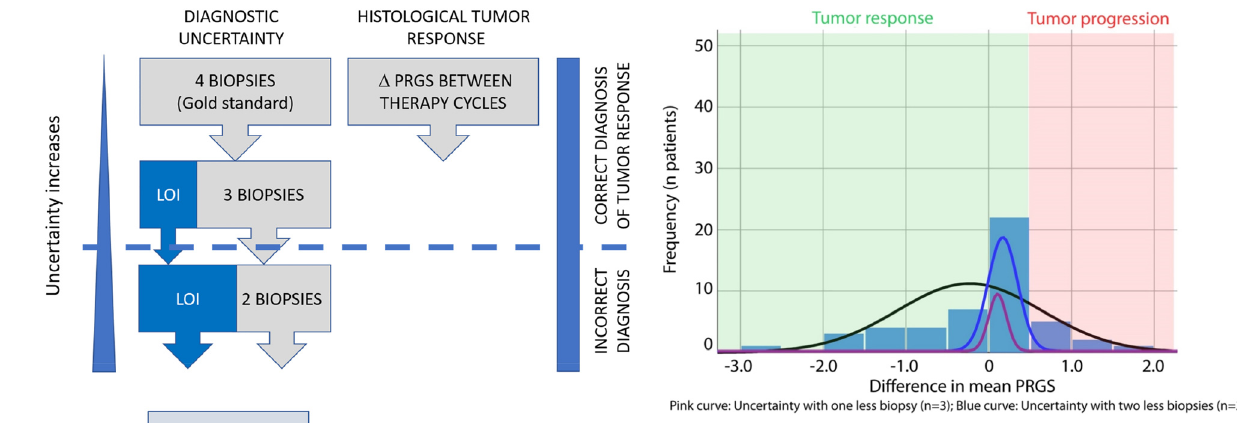
Figure 2: Histological tumor response and informational loss induced by missing biopsies. The tumor response is measured as the absolute difference of the mean PRGS between two therapy cycles. Progression of disease (PD) is defined by an increase in the mean PRGS (red area). Tumor response(green area) is defined by an unchangedPRGS (stable disease,SD), a decreasein the mean PRGS (partial response, PR), or the absence of vital tumor cells in all biopsies(PRGS1, completeresponse,CR).The pink curveshowsthe diagnostic uncertainty induced by one missing biopsies (= only three biopsies available), the blue curve by two missing biopsies (= only two biopsies available). Diagnosis of tumor progression is wrong when the diagnostic uncertainty is superior to the difference in the mean